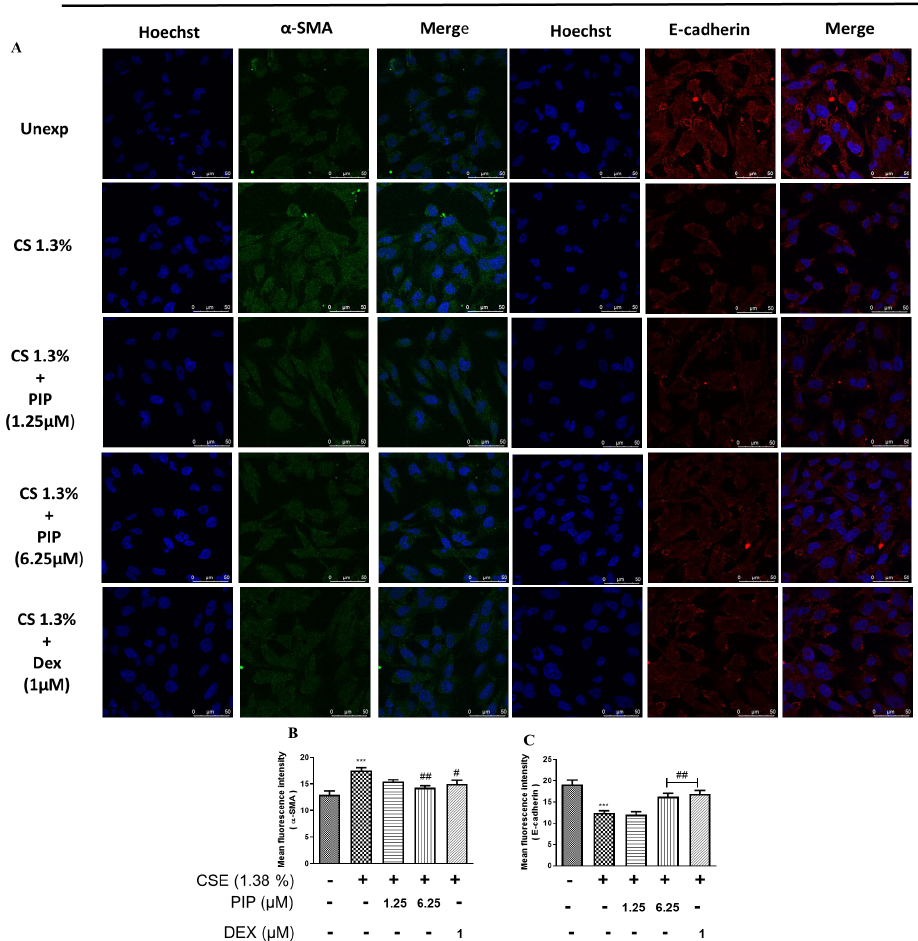
Figure 5. Effect of piperine treatment on expression of EMT signaling in CSE-exposed airway cells. ( A ) Immunofluorescence staining assay in BEAS-2B cells representing an expression of α -SMA, E-cadherin. Bar graphs representing a mean fluorescence intensity of ( B ) α -SMA and ( C ) E-cadherin. The values are expressed as mean ± SEM ( n = 3). *** p < 0.001 vs. Unexposed and # p < 0.05, ## p < 0.01 vs. CSE. For BEAS-2B cells: CSE: cigarette smoke extract-treated (1.38%), CS + PIP (1.25): cigarette smoke extract + 1.25 µM PIP, CS + PIP (6.25): cigarette smoke extract + 6.25 µM PIP, CS + DEX (1): cigarette smoke extract + 1 µ M